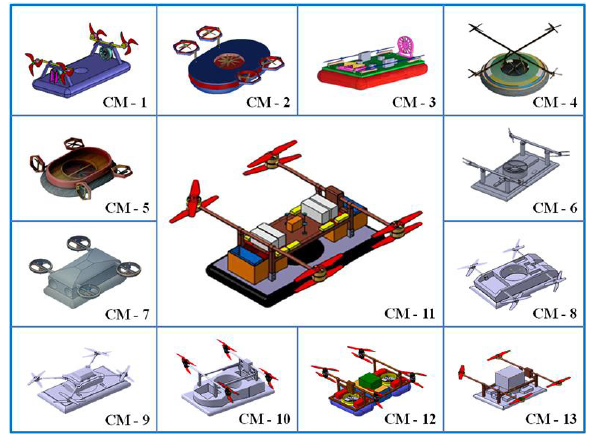
Figure 6. Conceptual models of